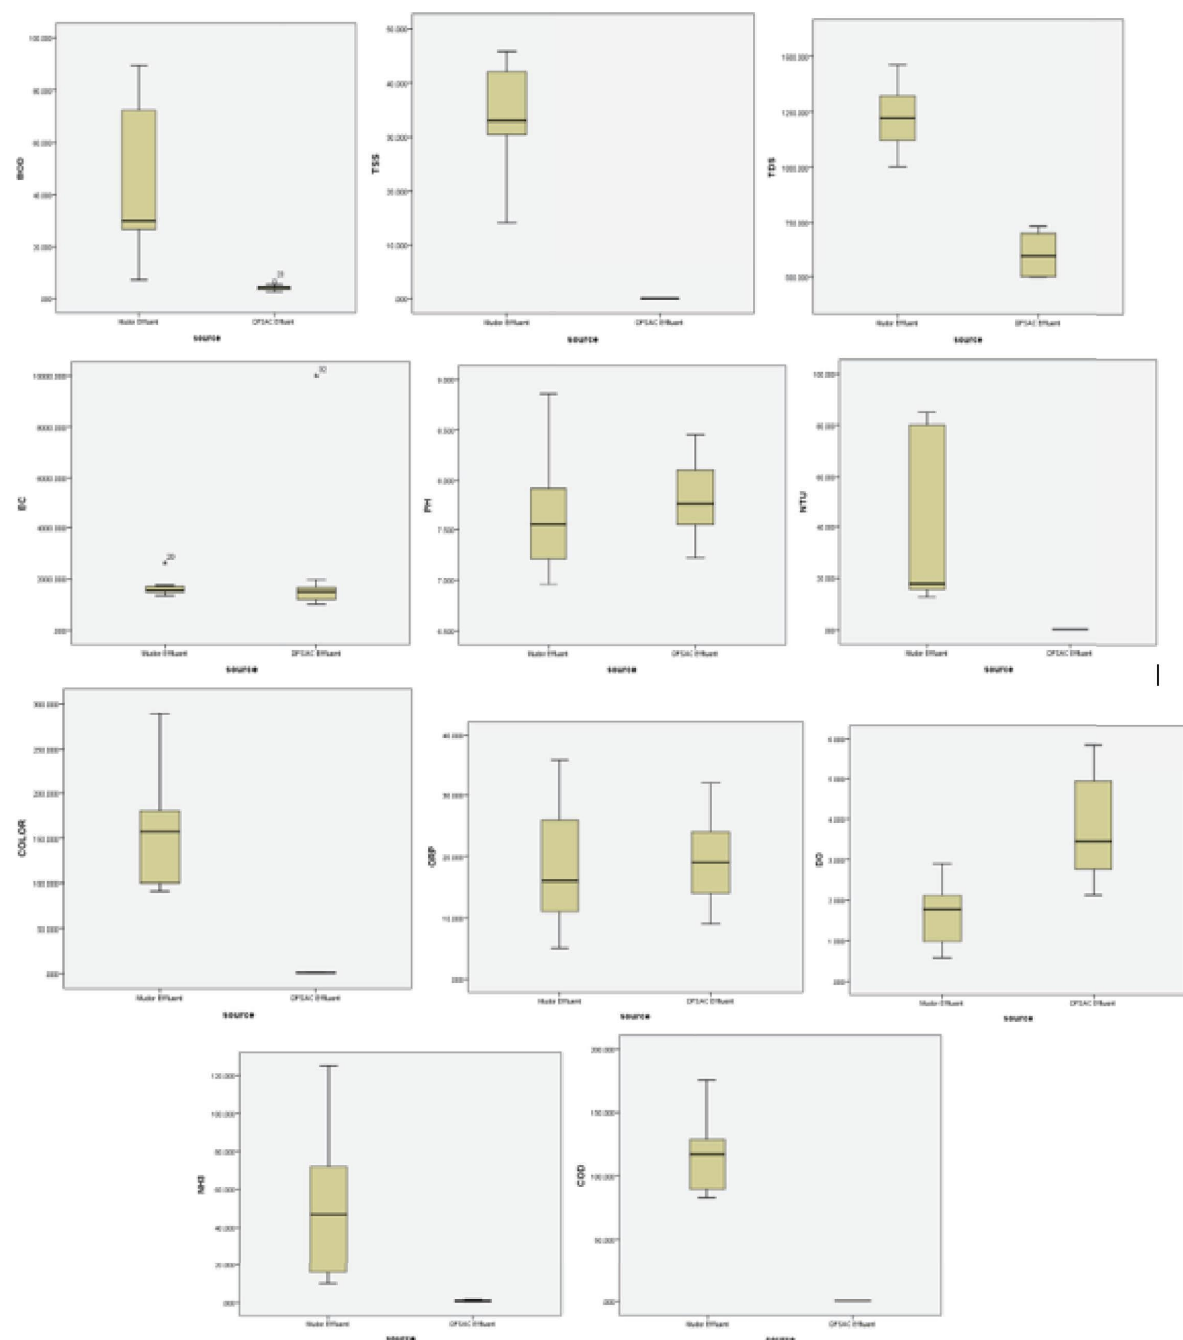
Figure 5: Boxplot of efuents from the treatment plant and the lab-scale